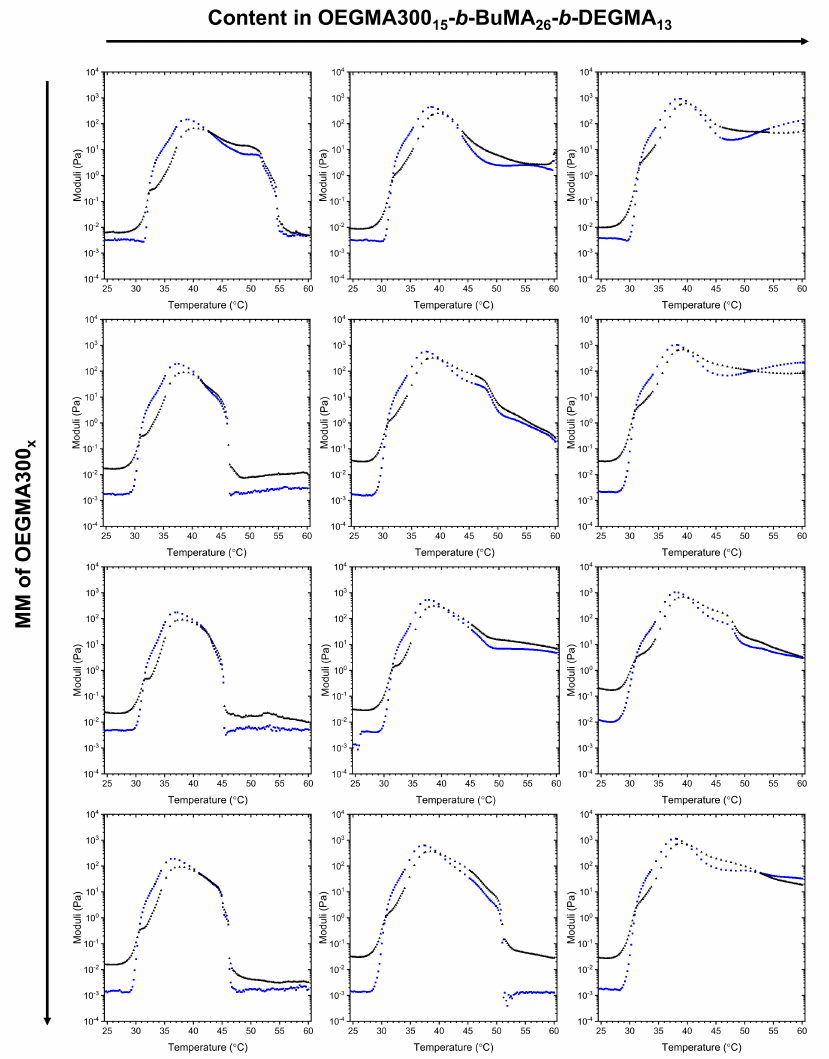
Figure 3. Storage modulus (G’, in blue squares) and loss modulus (G”, in black triangles) as a function of temperature. The formulations consisted of 20 w/w % total polymer concentration in phosphate buffered saline, and the ratio of P1/OEGMA300 x was kept equal to 1:3, 1:1, and 3:1; this is shown from left to right. The MM of OEGMA300 x homopolymers was also varied from 10, 31, 43, to 75, shown from top to